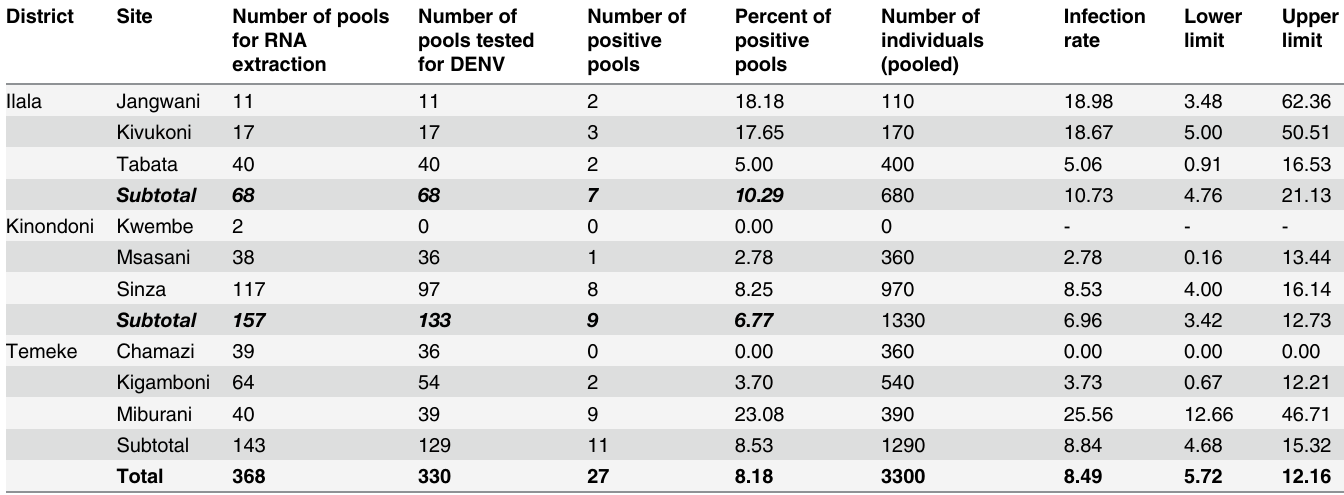
Table 4. Number of mosquito pools tested and DENV infection in Aedes aegypti by study sites in Dar es Salaam. District